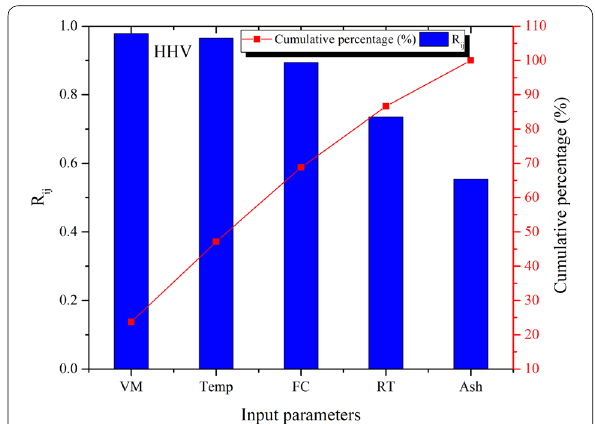
Fig. 13 Input parameters contributions to the predicted